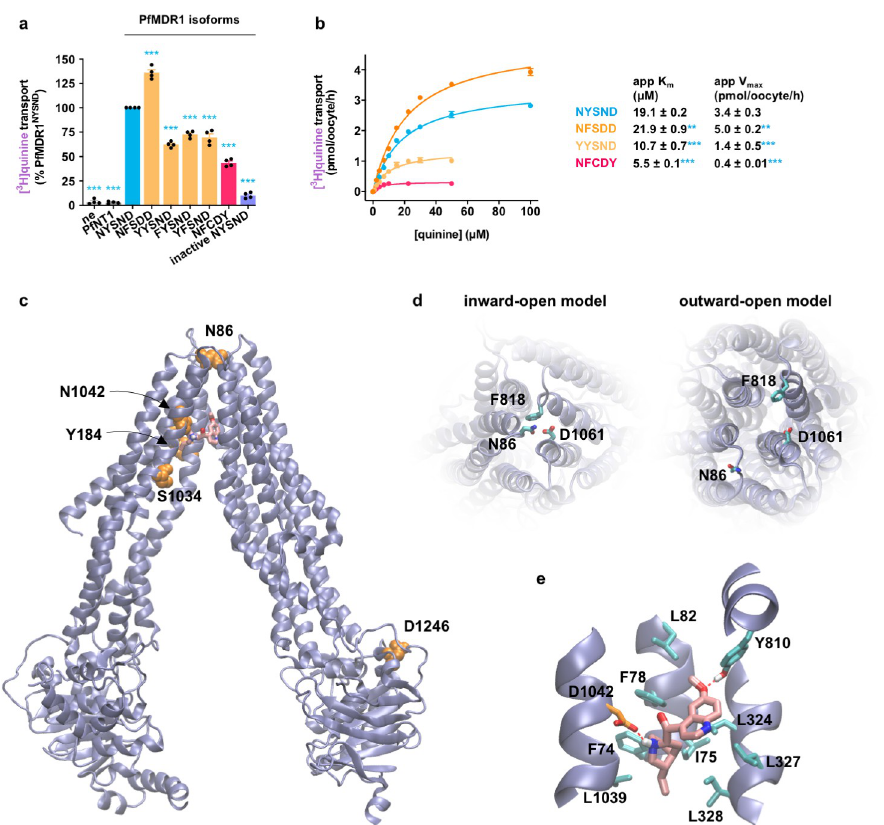
Fig 4. Quinine transport via PfMDR1. (a) Field isoforms of PfMDR1 transported [ 3 H]quinine, with PfMDR1 NFSDD exhibiting the highest level of quinine transport activity. (b) There were significant differences in the apparent kinetic parameters for quinine transport via field isoforms of PfMDR1. The concentration dependence of PfMDR1-mediated quinine transport was calculated by subtracting the leakage from ne from that of oocytes expressing a PfMDR1 isoform at each drug concentration. The data are the mean of n = 4 independent experiments (each yielding similar results and overlaid as individual data points in panel a ), and the error is the SEM. The asterisks denote a significant difference from PfMDR1 NYSND ; �� P < 0.01 and ��� P < 0.001 (1-way ANOVA). The data underlying panels a and b of this figure is supplied in S3 Data. (c) Inward-open homology model of PfMDR1 based on the C . elegans P-gp crystal structure (PDB 4F4C) showing the location of the mutations found in the 5 field PfMDR1 isoforms characterized in this study (orange). A putative binding pose of quinine in the central cavity is shown (pink). (d) A comparison of the inward- open model and outward-open models (based on the crystal structure of human P-gp; PDB 6C0V) as viewed from the side of the protein facing into the DV lumen. The N86Y mutation is part of a cluster of 3 residues forming the extracellular gate of the transporter (the participating residues are shown). These 3 residues are in close proximity in the inward-open state but move apart in the outward-open conformation. (e) Putative quinine binding site in PfMDR1 NFSDD . Amino acids interacting with quinine are indicated (apart from L71, I1071, and F1072 that are removed to clearly view the binding pose). Atoms are shaded as follows: carbon in quinine, pink; carbon in the 1042D residue, orange; nitrogen, blue; oxygen, red; hydrogen, white. ne, nonexpressing oocytes; PfMDR1, Plasmodium falciparum multidrug resistance protein 1; P-gp, P-glycoprotein.